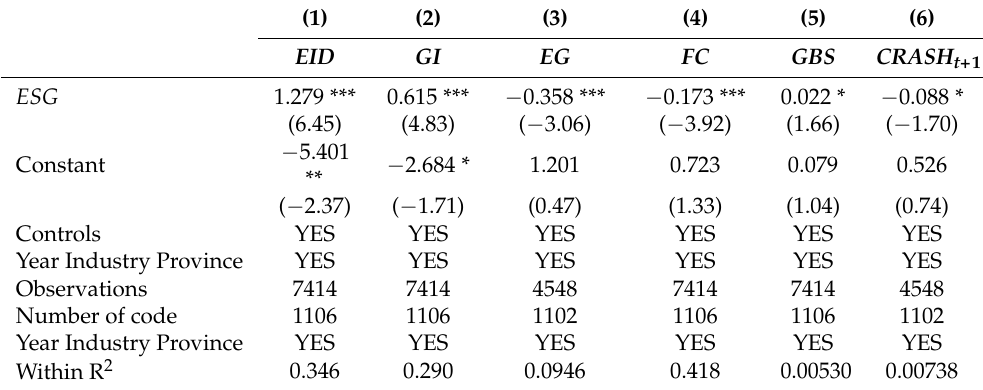
Table 7. Spillover effects of ESG scores: green performance and financial